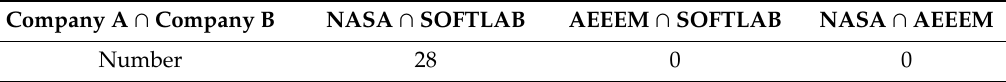
Table 3. The number of common features between projects of di ff erent